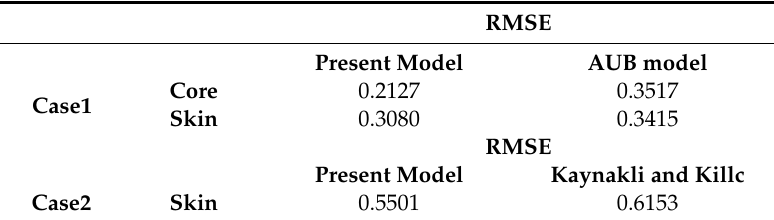
Table 3. Root mean square error results of different models.